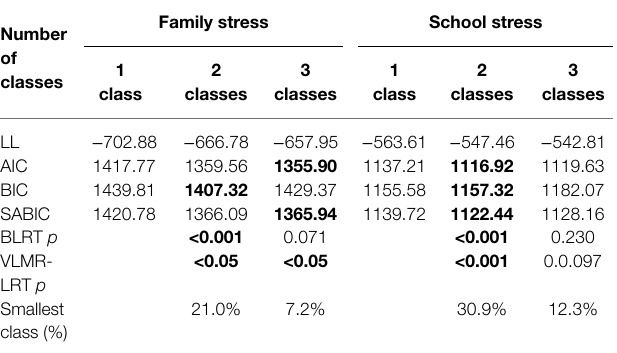
TABLE 2 | Fit statistics and classification coefficients for the LCA results for stress experienced at home and in school. Number